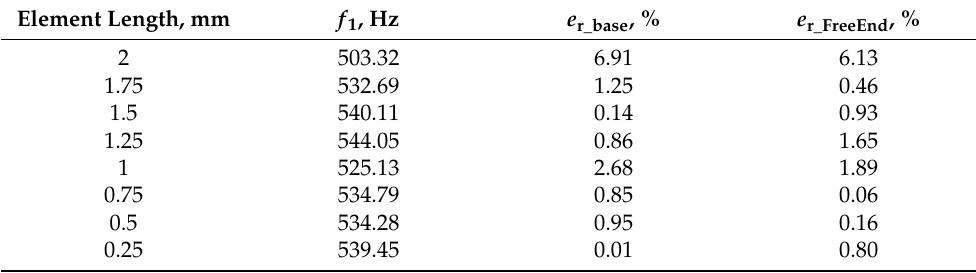
Table 3. Mesh sensitivity validation for hexahedral (brick) elements with merged nodes.